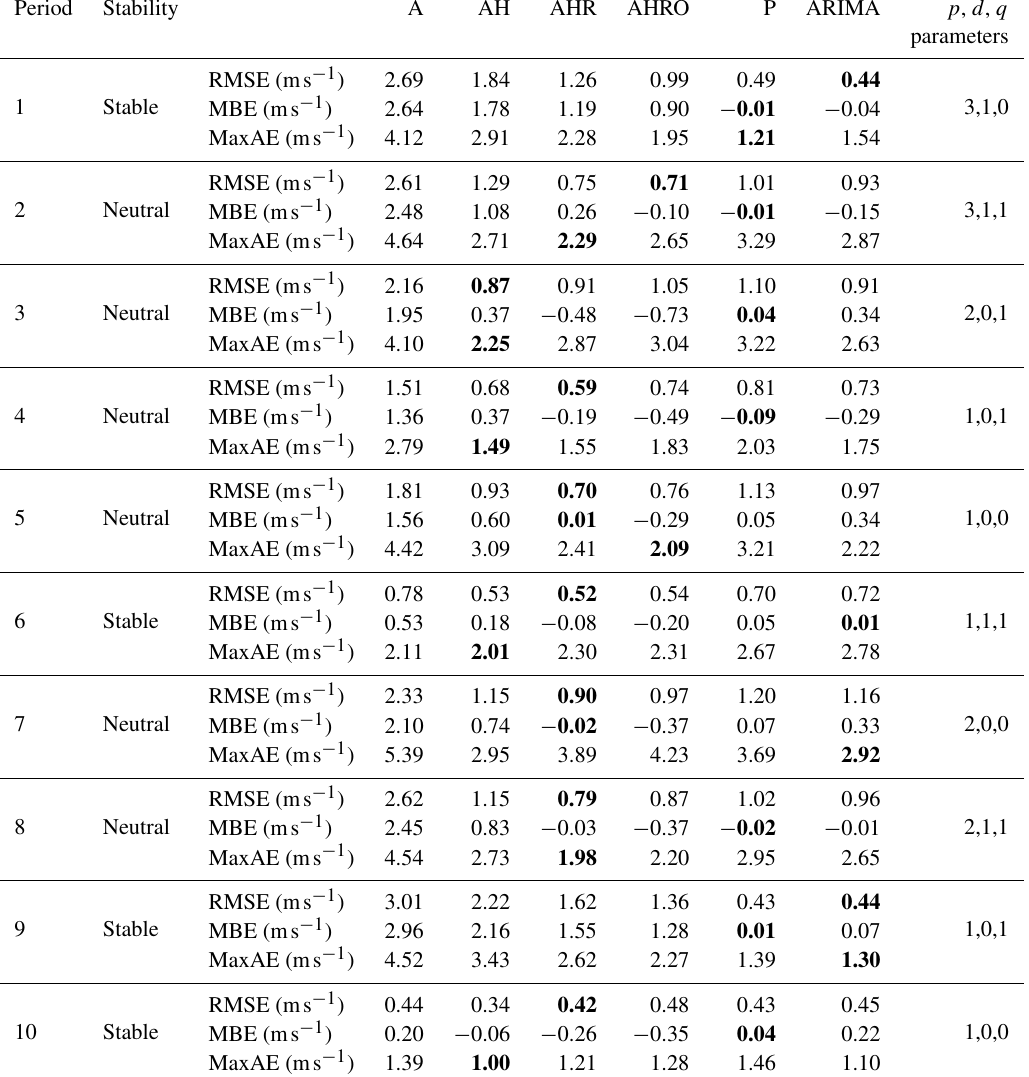
Table 3. RMSE, MBE and MaxAE statistics for all periods evaluated. Minimum values are indicated in bold. Period